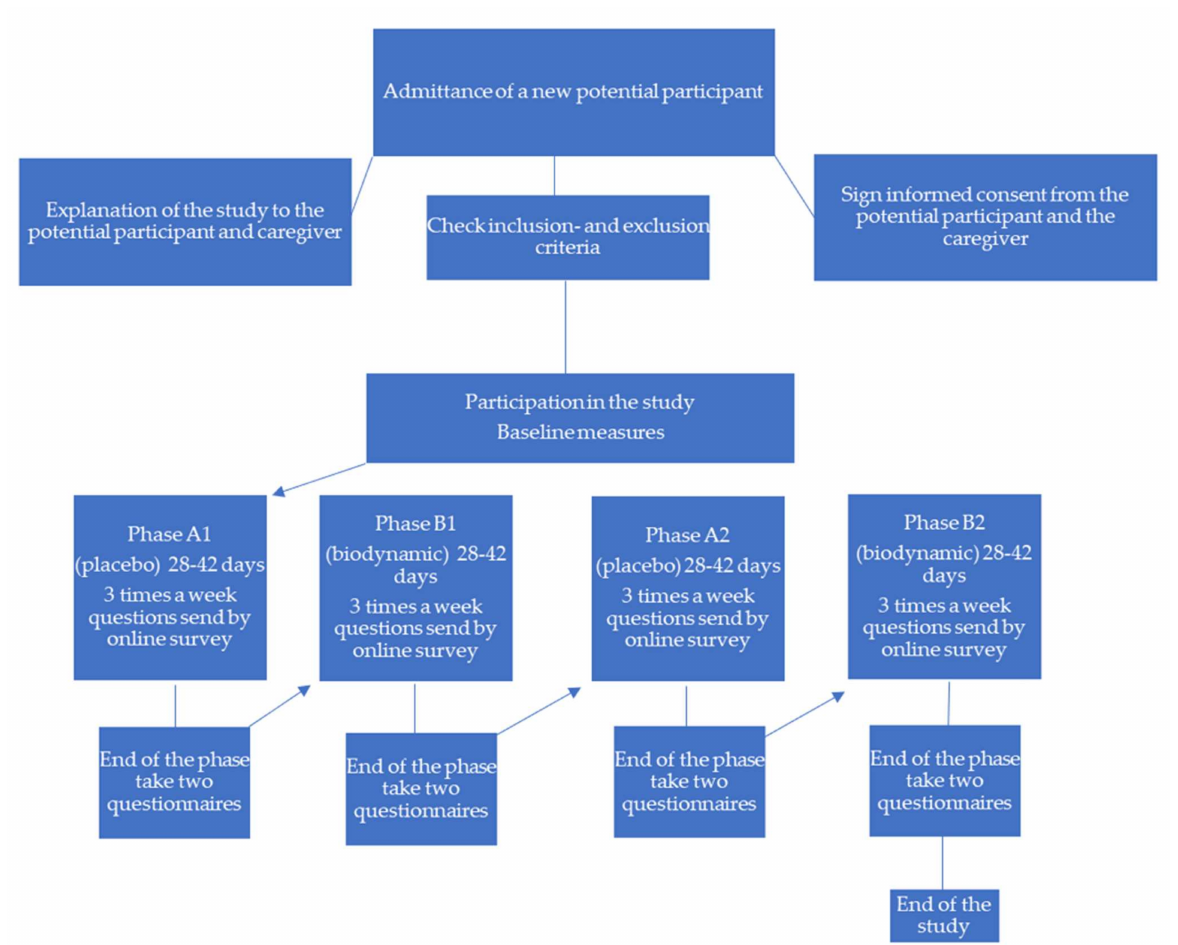
Figure 1. Schematic representation of the research